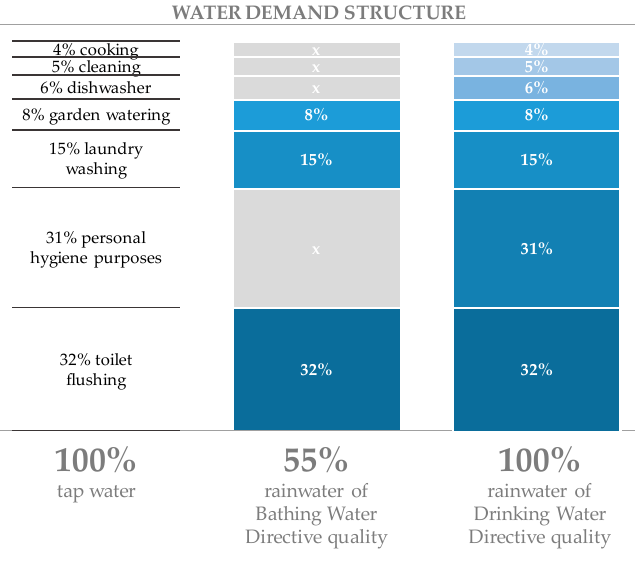
Figure 1. Rainwater ratio in residential water demand depending on the quality of supplied rainwater according to the European Water Directives.